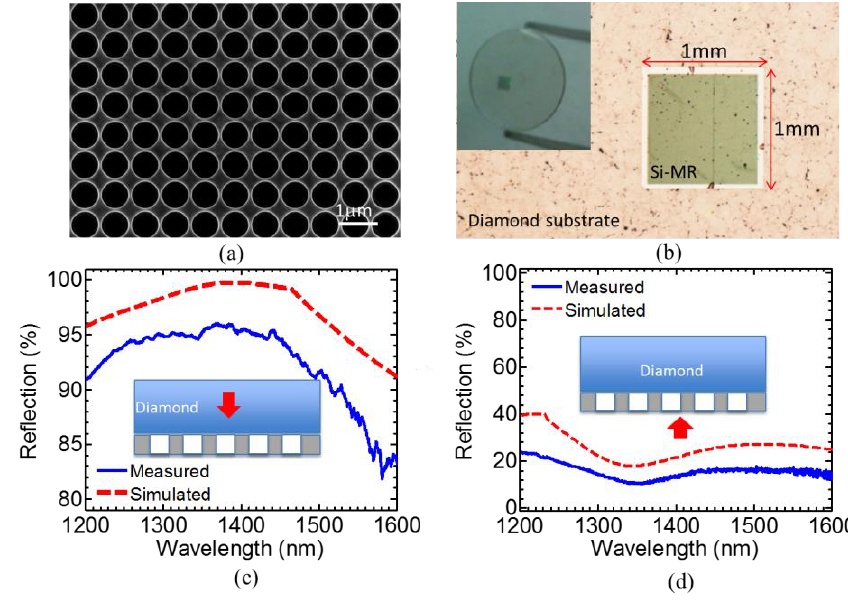
Figure 4. Si MRs transfer on diamond substrate. ( a ) A SEM image of PC structure patterned on SOI; ( b ) Optical microscopic images of Si MR reflector transferred on diamond substrate, with the inset shown the complete view; ( c ) Measured and simulated reflection spectra for Si MR on diamond with incidence from the diamond substrate side; and ( d ) with incidence from top Si MR side. Reproduced with permission from